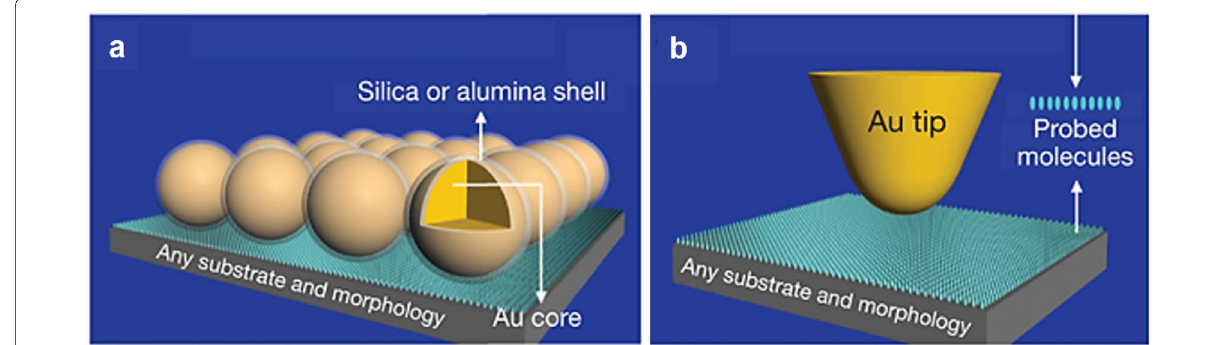
Fig. 3 The comparison between SHINERS working principle with other a shell-isolated mode: SHINERS. b non-contact mode: tip-enhanced Raman spectroscopy, reproduced with permission from [21]. Copyright (2010) Macmillan Publishers Limited